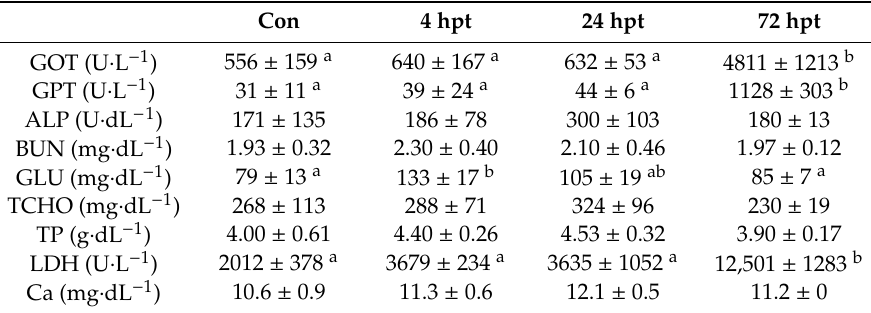
Table 1. Changes of serological indicators after acute thermal stress.